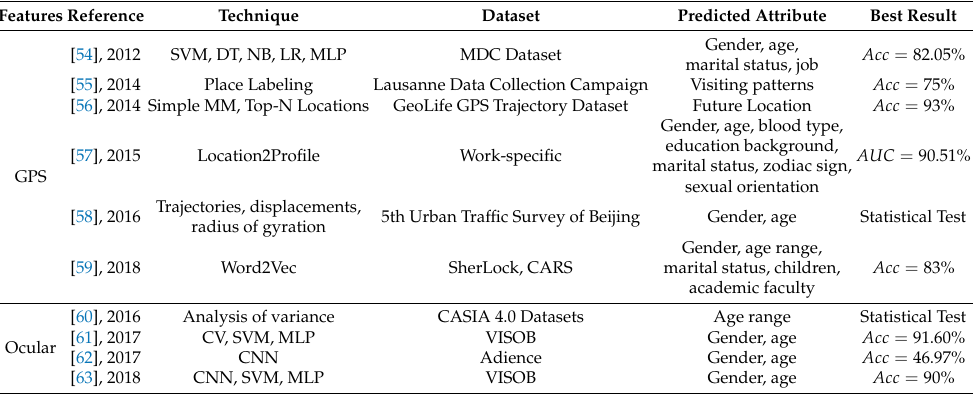
Table 2. Sensor-based User Profiling (UP) literature summary (Acc: Accuracy, AUC: Area Under the Curve, CNN: Convolutional Neural Networks, CV: Computer Vision, DT: Decision Tree, LR: Logistic Regression, MLP: Multi-Layer Perceptrons, MM: Markov Model, NB: Naive Bayes, SVM: Support Vector